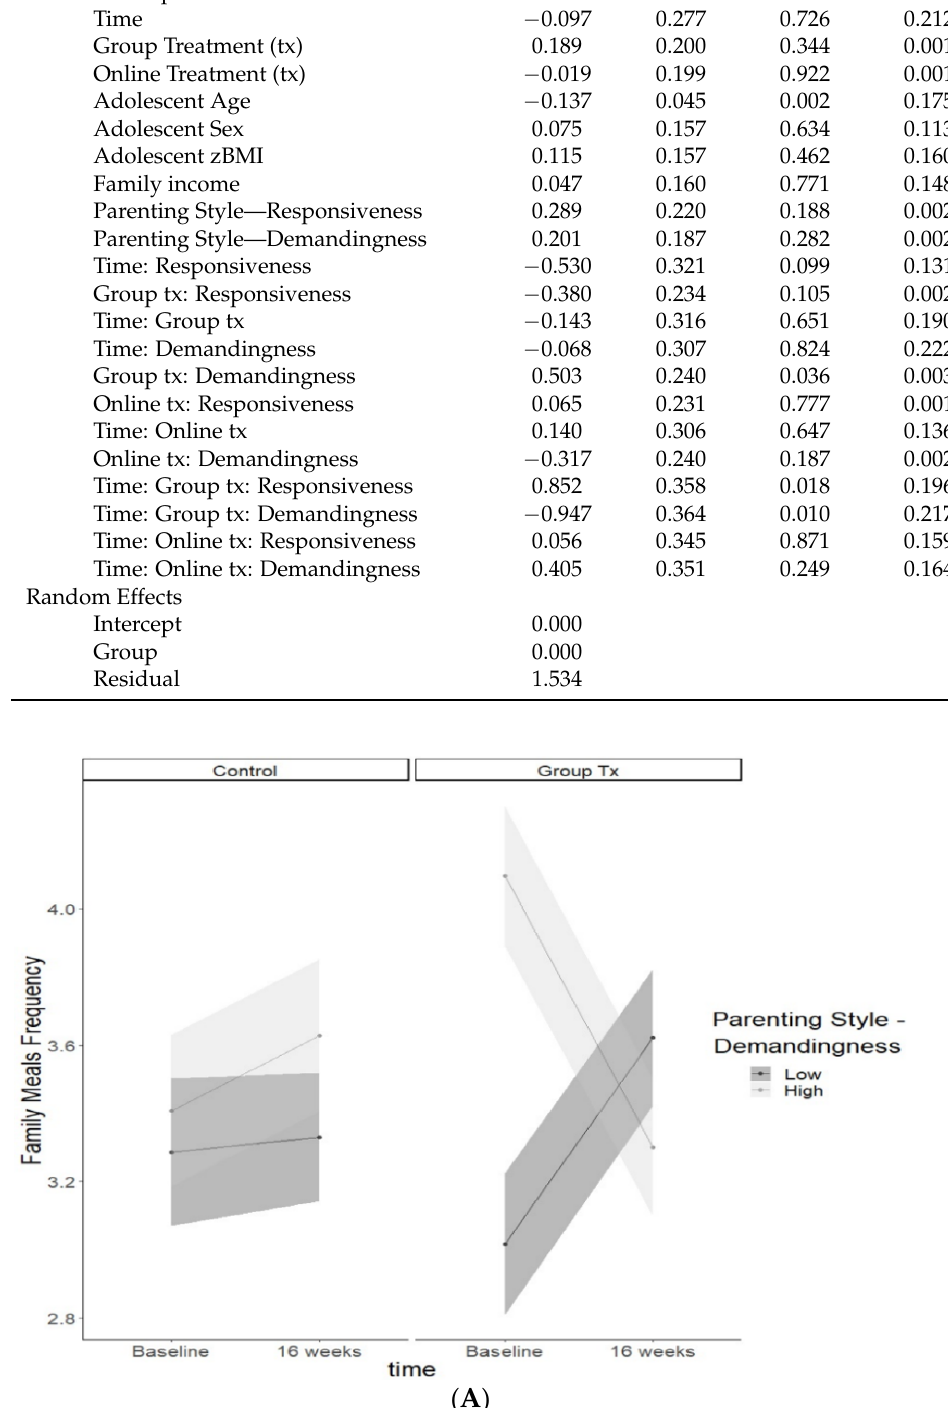
( B ) Figure 1. Three-way interaction between time x group treatment x demandingness ( A ) and time x group treatment x responsiveness ( B ) predicting frequency of family meals. 3.4. Parenting Feeding Practices A second multilevel model was conducted to evaluate interactions between time, treatment, and parental feeding practices (concern, restrict, pressure to eat) on frequency of family meals at 16 weeks (see Table 4). Again, there was a significant main effect for adolescent age (estimate = − 0.123, SE = 0.047, p = 0.009). There were two significant two- way interactions, including time x restrict (estimate = − 0.680, SE = 0.332, p = 0.042) and online treatment x concern (estimate = 0.542, SE = 0.223, p = 0.015). As shown in Figure 2, the time x restrict interaction revealed that lower restriction was associated with an in- crease in the frequency of family meals from baseline to 16 weeks, whereas higher re-